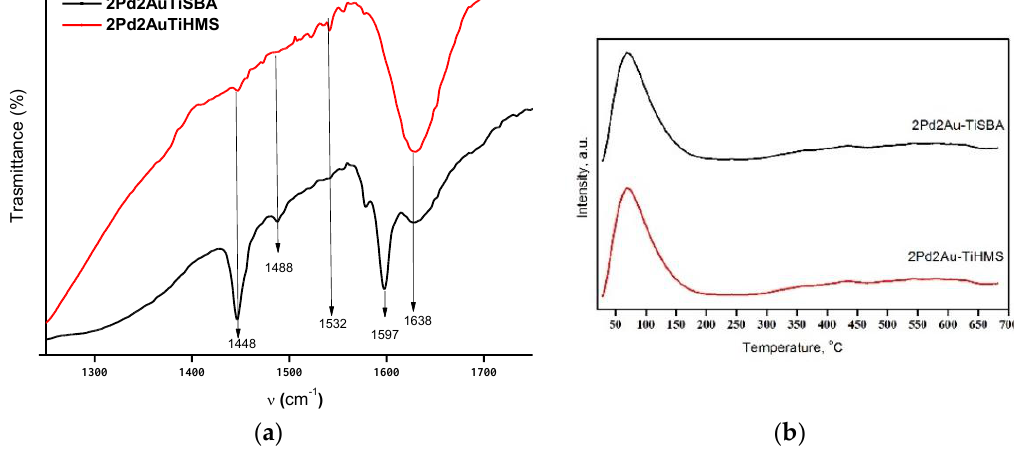
Figure 7. Py-IR ( a ) and NH 3 -TPD ( b ) spectra of 2Pd2AuTiHMS and 2Pd2AuTiSBA.